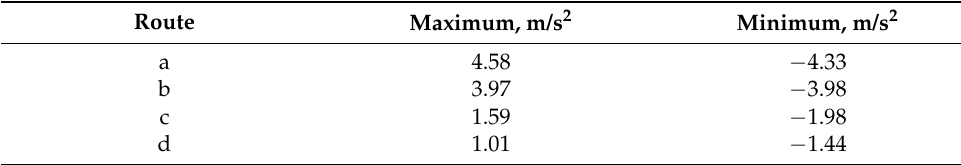
Figure 4. Values of lateral acceleration at specific sections on various road types: ( a ) urban area (city); ( b ) non-urban area (single roadway with two traffic lanes); ( c ) two-roadway expressway; ( d ) motorway. Table 2. Lateral acceleration at specific road